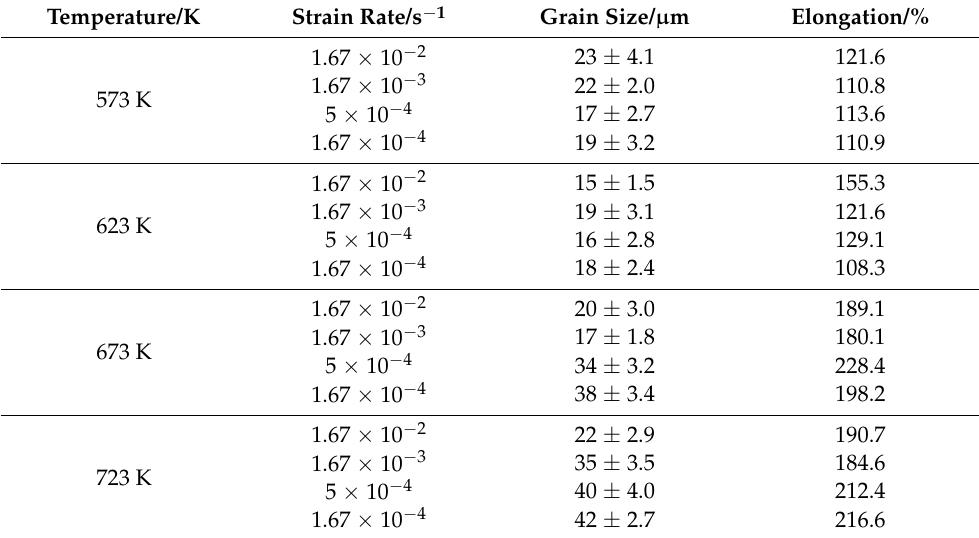
Table 1. Grain sizes and elongations of GAZ211 alloy tensiled at different temperatures and strain